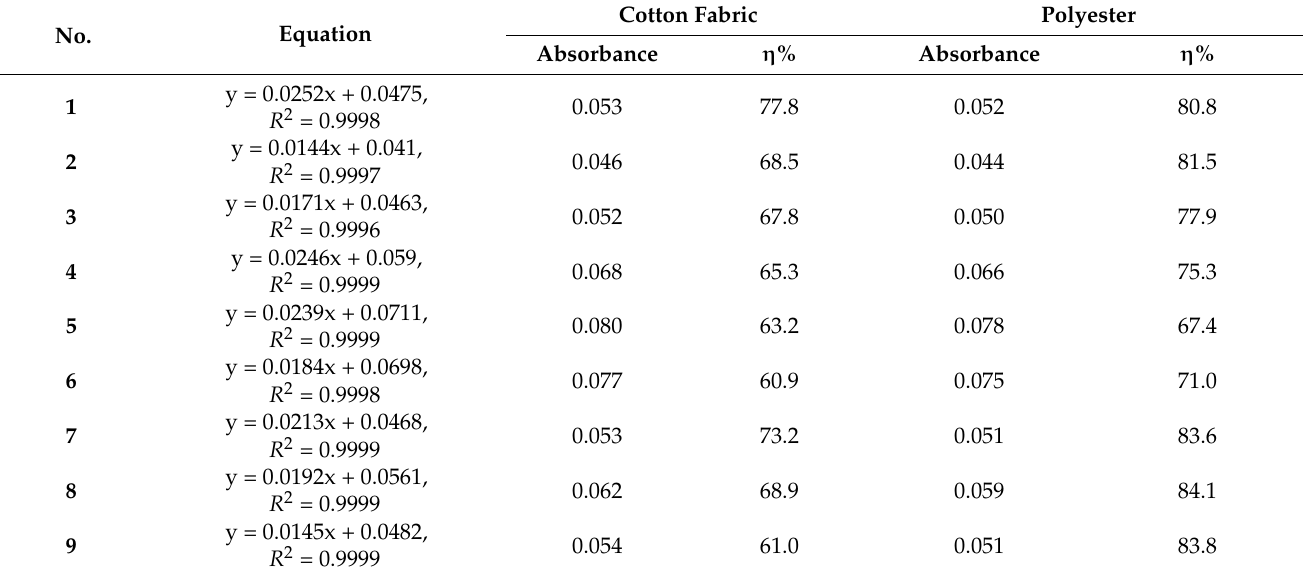
Table 2. Residual absorbance and dyeing rate of the nine UV